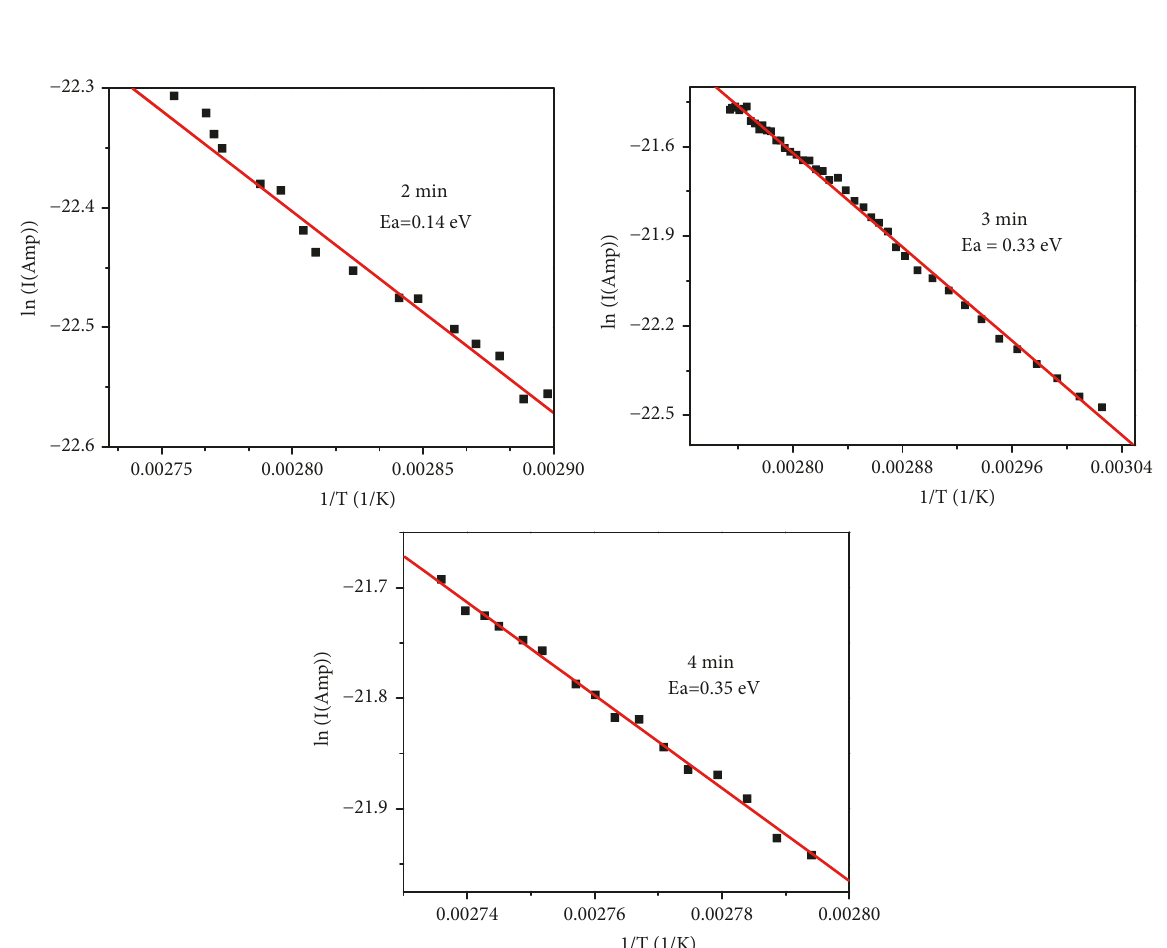
Figure 7: Plots of ln ( I ) vs (1/ T ) of PbS thin film as a function of deposition